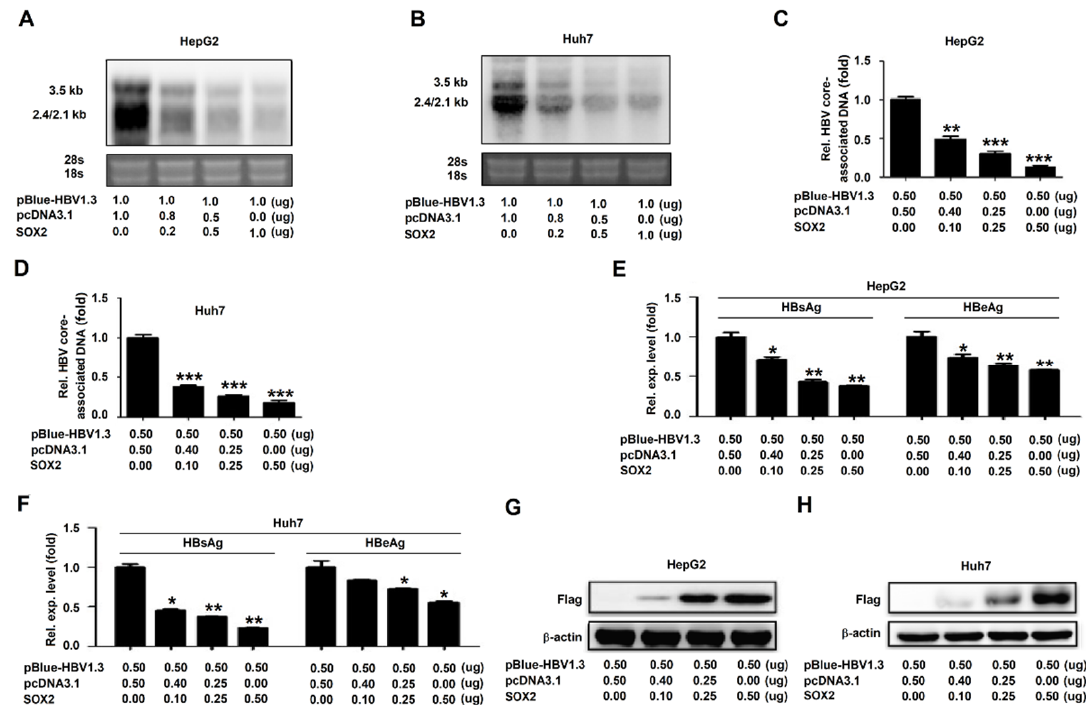
Figure 2. SOX2 represses HBV replication in HepG2 cells and Huh7 cells. ( A – H ) HepG2 cells (A, C, E, and G) and Huh7 cells (B, D, F, and H) were plated in 6-well plates and then co-transfected with pBlue-HBV1.3 and pcDNA3.1 or pcDNA3.1-SOX2 at di ff erent concentrations for 48 h. Total RNA was extracted and HBV RNAs were determined by Northern blot. The 28s and 18s rRNAs were used as the internal controls (A and B). HBV core-associated DNA was extracted and detected by qRT-PCR (C and D). HBsAg and HBeAg in cell culture supernatant were analyzed by ELISA (E and F). SOX2 and β -actin were detected by Western blot (G and H). *, p < 0.05, **, p < 0.01 and ***, p <